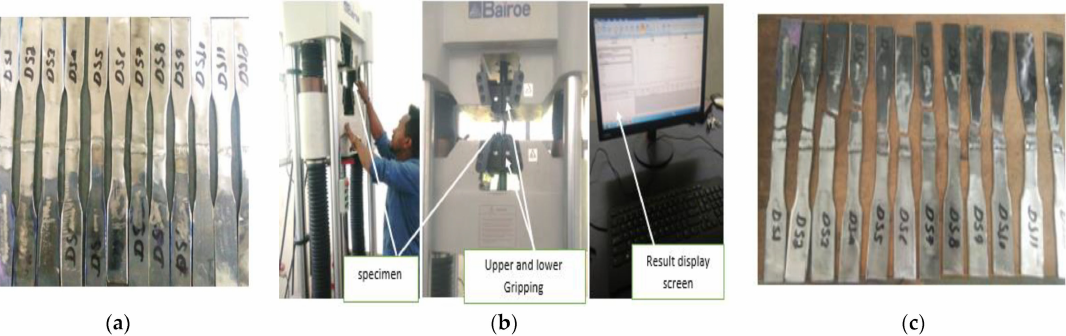
Figure 9. Specimen prepared for tensile strength, ( a )Tensile Specimens ( b ) set-up, and ( c ) fractured specimens.